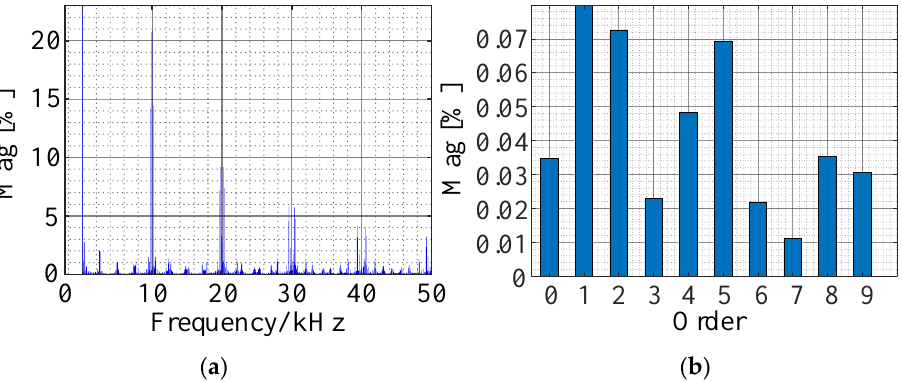
Figure 5 shows the low-order harmonic distribution of the line-to-line stator voltage u ab and the stator current i as using SVPWM without deadtime and conduction voltage drop of switching devices. Except for the fundamental component, the harmonics of u ab only include the high-order harmonic components around the switching frequency and its integer multiples. So only a few low-order harmonic components exist in the i as .